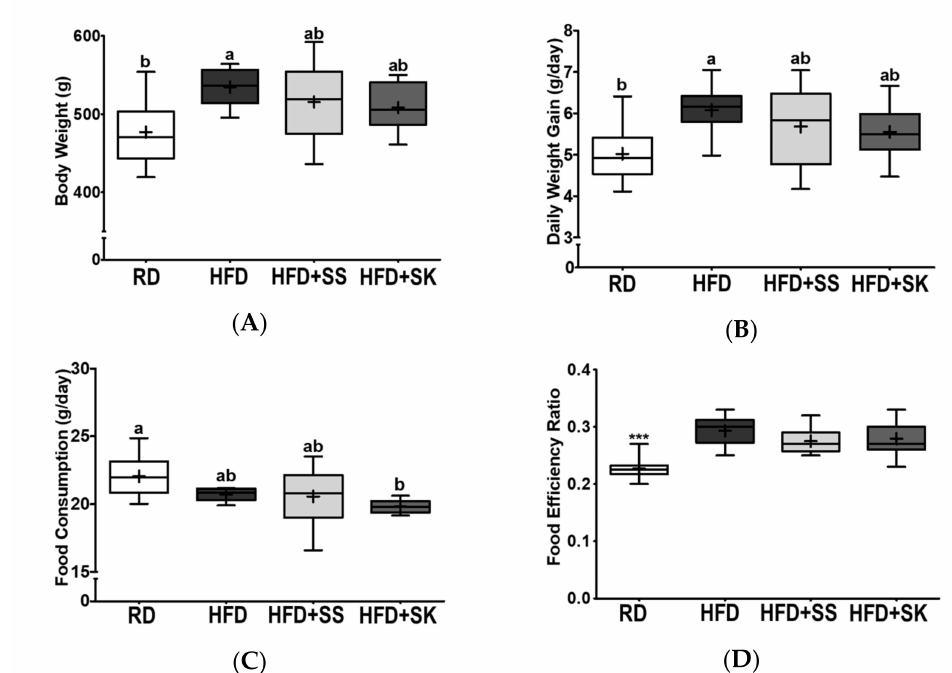
Figure 1. Effects of steamed soybean (SS) and soybean koji (SK) on final body weight, daily body weight gain, daily average food consumption, and food efficiency ratio in HFD-fed Sprague-Dawley rats. Experimental rats were fed a regular diet (RD) or a high-fat diet (HFD) with 3% SS (HFD+SS) or with 3% SK (HFD+SK) for 8 weeks. ( A ) The final body weight, ( B ) daily body weight gain ((the final BW after dietary feeding—the initial BW)/day), ( C ) daily average food consumption, and ( D ) food efficiency ratio were measured or calculated. RD, regular diet; HFD, high-fat diet; HFD+SS, high-fat diet + 3% steamed soybean; HFD+SK, high-fat diet + 3% steamed soybean. Values are displayed as a box-and-whisker plot with means (expressed as ‘+’), n = 8. Data were analyzed using one-way ANOVA followed by Tukey’s post-hoc comparison. Means labeled without a common letter differ significantly, * p < 0.05. *** p <